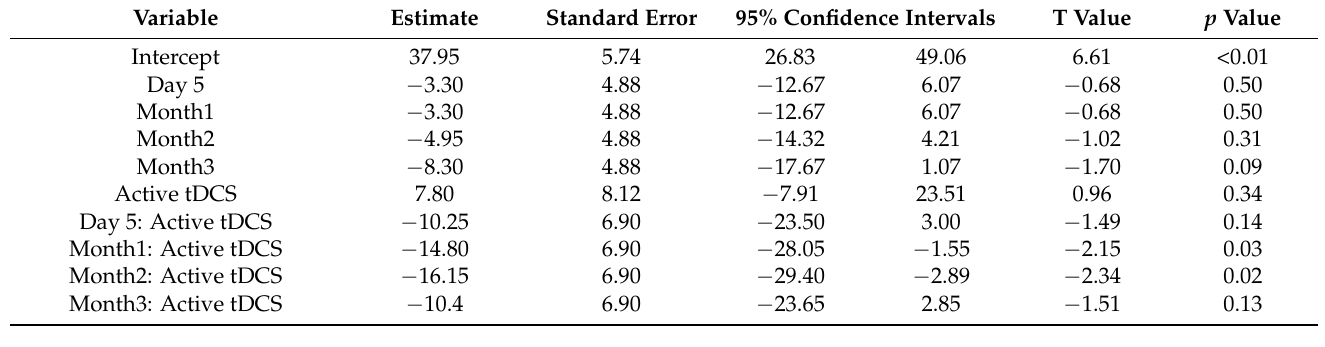
Table 4. Profile analysis results for Mobilization Observation Behaviour Intensity Dementia (MOBID).